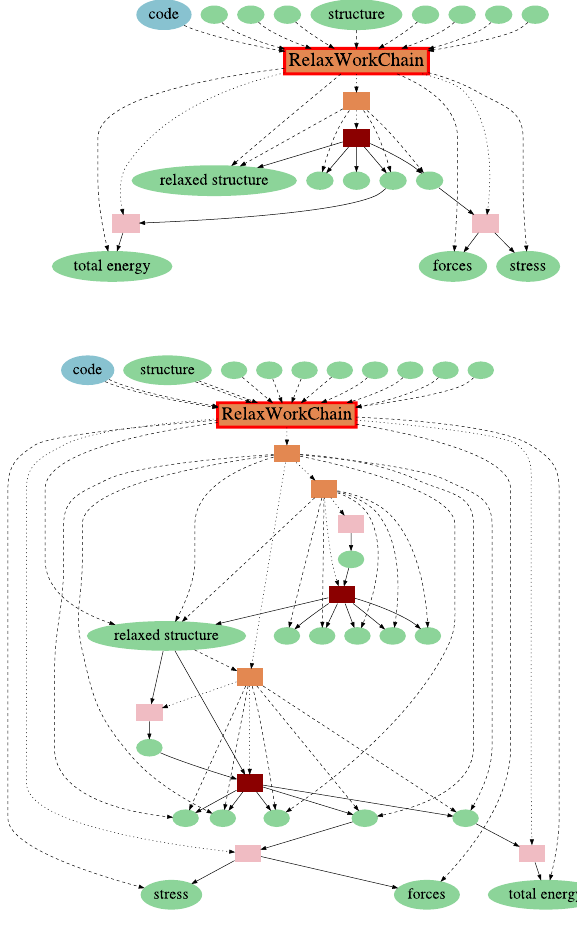
Fig. 5 Schematic provenance graph for relaxation work fl ows. Schematic provenance graphs for a relaxation work fl ow powered by two different quantum engines (top: SIESTA; bottom: Quantum ESPRESSO). The node of the <Code>CommonRelaxWorkChain is highlighted with the label “ RelaxWorkChain ” and with a red edge. All the AiiDA work chains called during the relaxation are represented by orange rectangles. The dark red rectangles are calculations, meaning calls to an external executable that performs a calculation, for instance, a call to the pw.x of Quantum ESPRESSO. All the ellipses represent data nodes, meaning nodes in the database that contain data, like, for instance, the initial structure, the total energy, and so on. In blue is the data node representing the code utilized for the calculations. In pink are represented calls to Python functions that modify some data in order to create